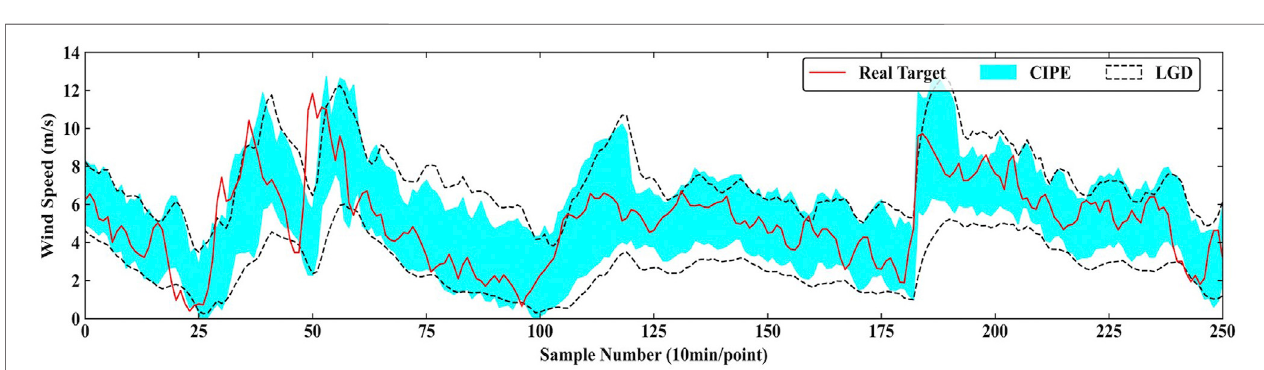
FIGURE 8 | Prediction result of CIPE and LGD under PINC = 90% in 3-step ahead prediction.